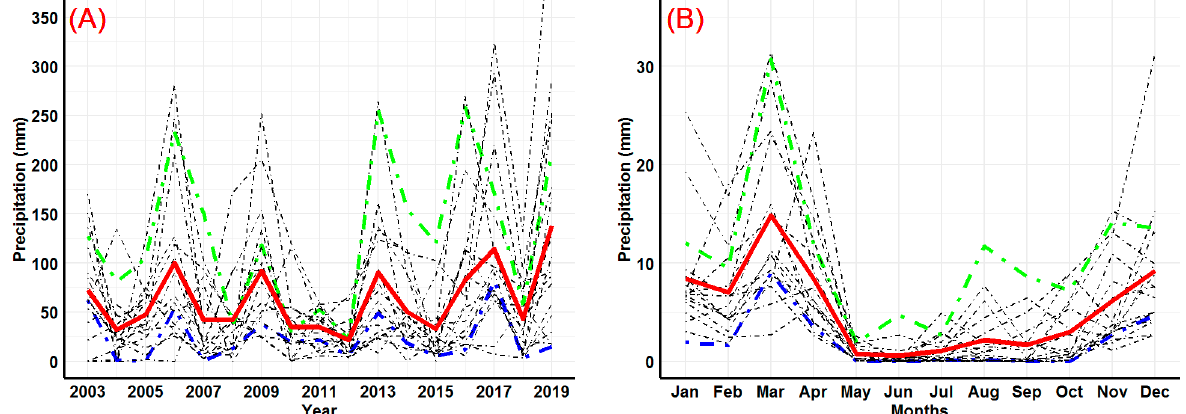
Figure 2. ( A ) Annual and ( B ) monthly average precipitation of all 18 rain gauge stations represented by dotted lines with the average of all stations is the bold red lines (blue and green dotted lines represent Alqlaa and Khatam Al Shaklah stations).